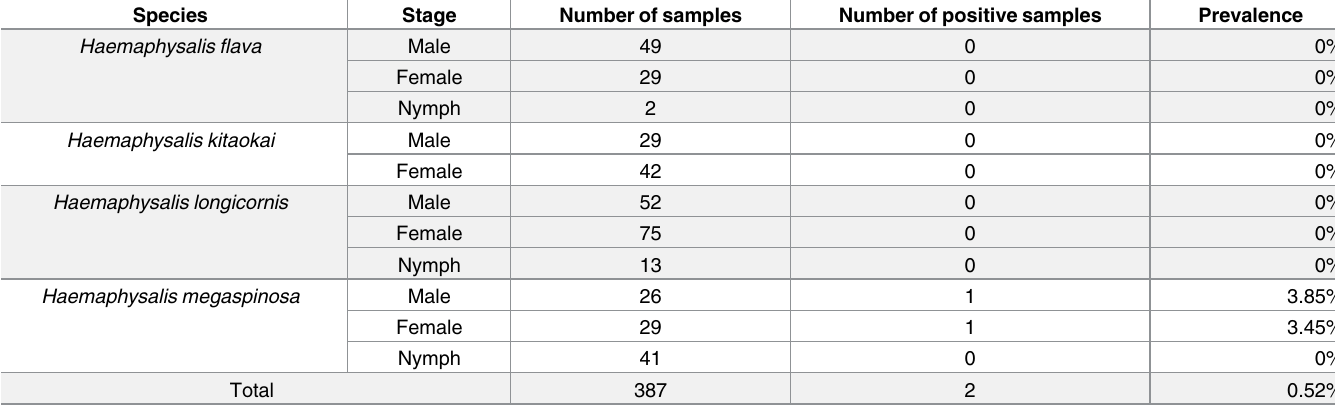
Table 1. Host-seeking ticks collected in Shimonoseki, Yamaguchi